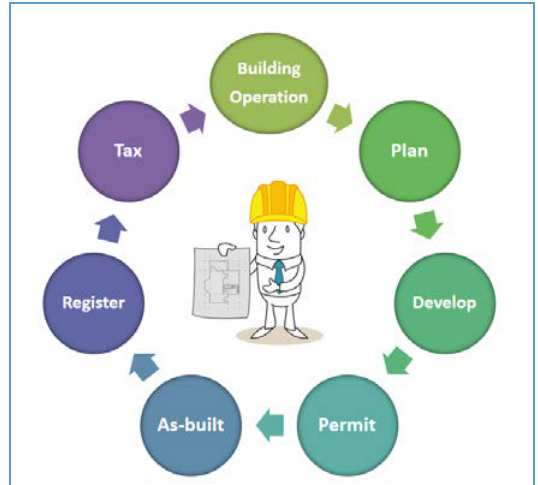
Figure 1: The life cycle of an engineering project that require map submission.